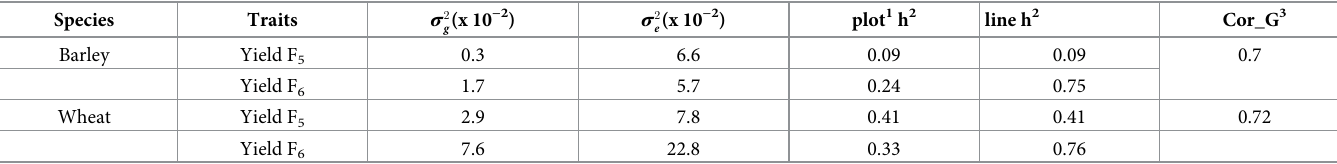
are given by 10 − 2 as base